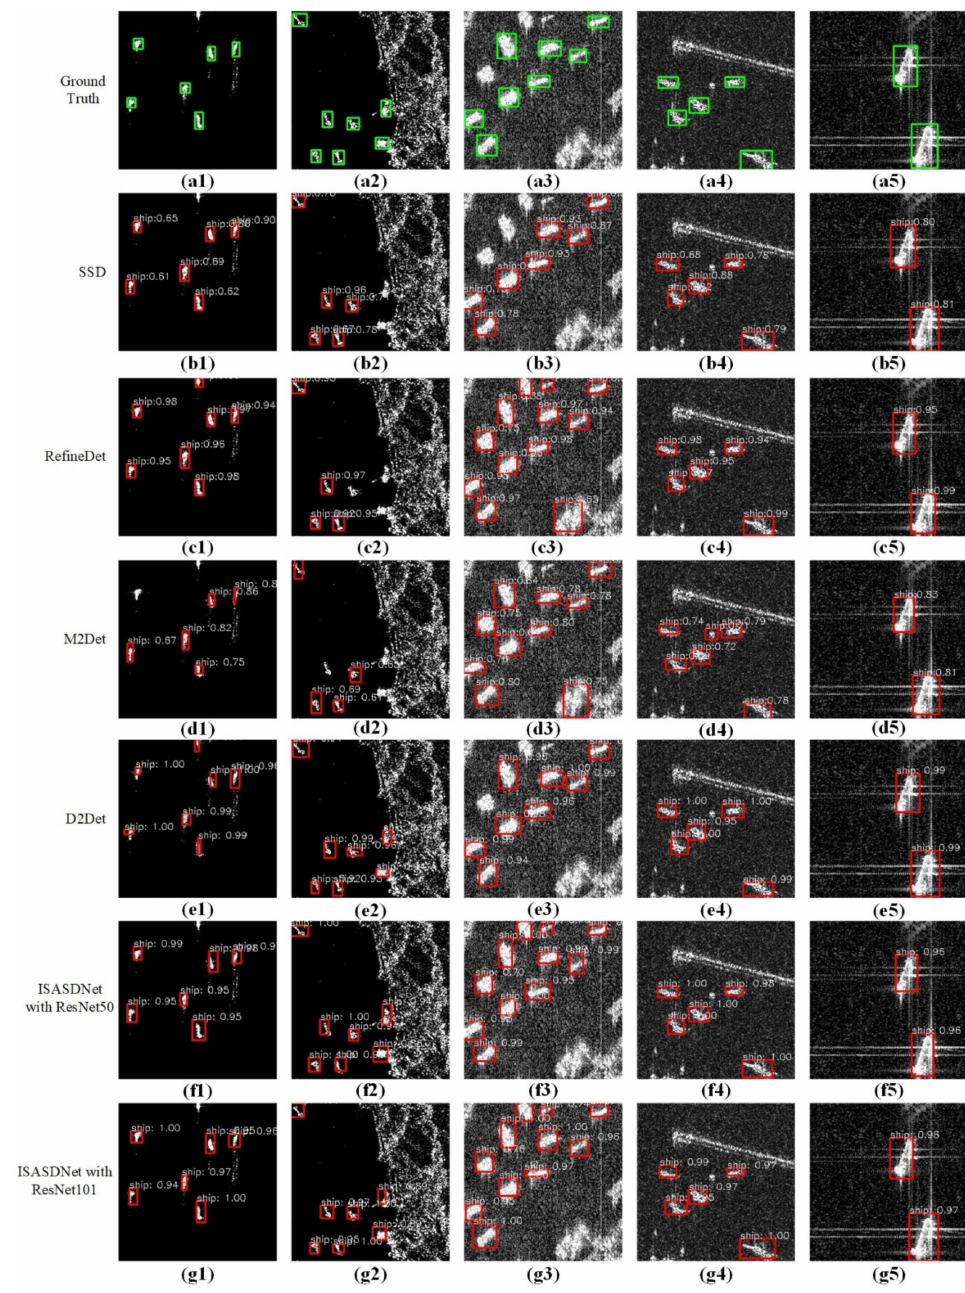
Figure 9. Experimental results on SAR-Ship-Dataset. ( a1 – a5 ) The first row contains ground truth images. ( b1 – b5 ) The second row contains the results of SSD. ( c1 – c5 ) The third row contains the results of RefineDet. ( d1 – d5 ) The fourth row contains the results of M2Det. ( e1 – e5 ) The fifth row contains the results of D2Det. ( f1 – f5 , g1 – g5 ) The last two rows contain the experimental results of our algorithm: the fifth row shows the results obtained by ISASDNet with ResNet50, and the sixth row shows the results obtained by ISASDNet with